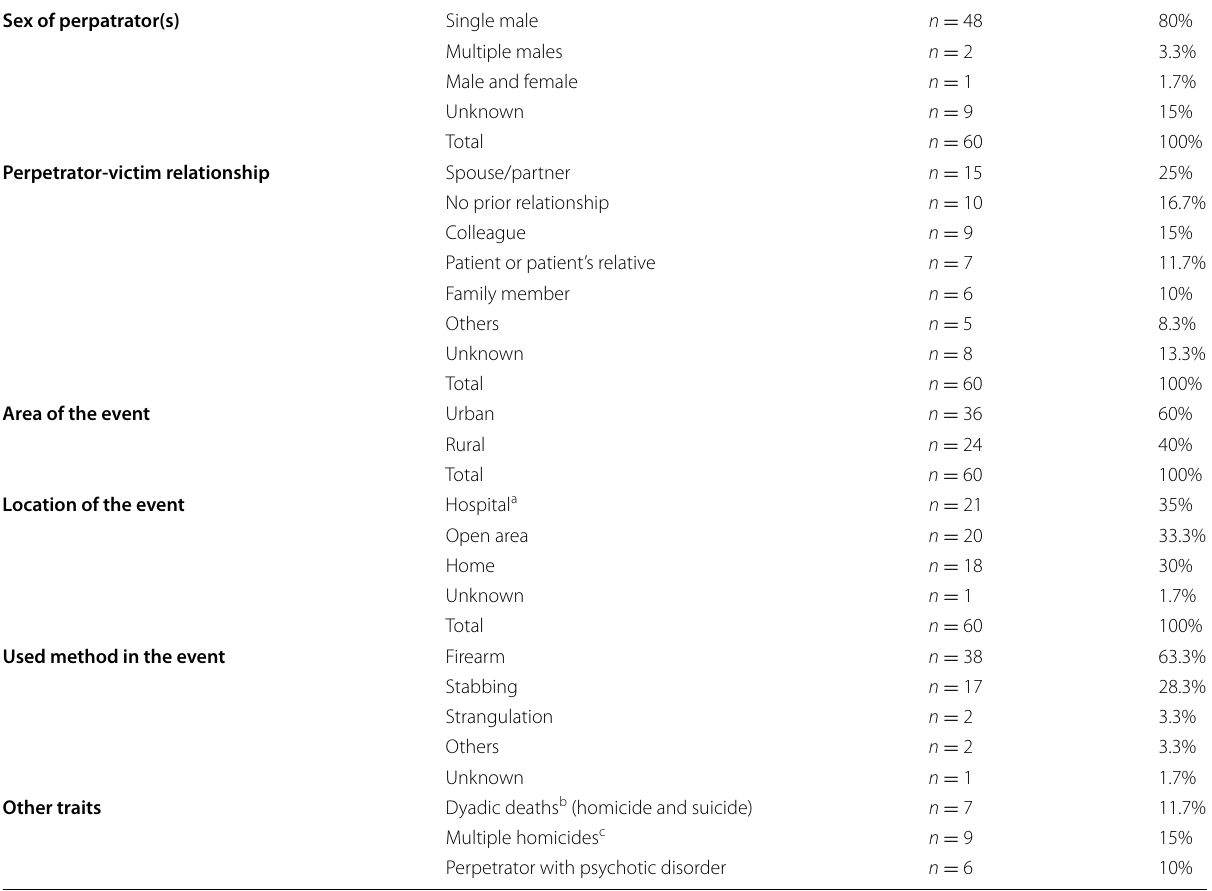
a Including two paramedics killed while on duty with the ambulance b Deaths which the perpetrator committed suicide after the homicide c Homicides in which at least two victims have been affected